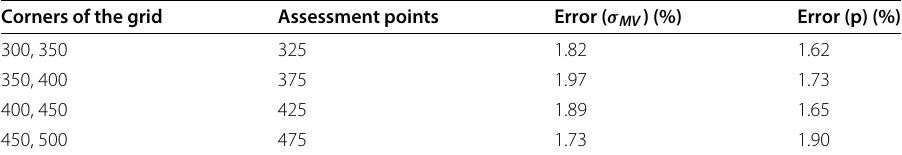
Table 5 RB errors of von Mises stress and plastic strain Corners of the grid